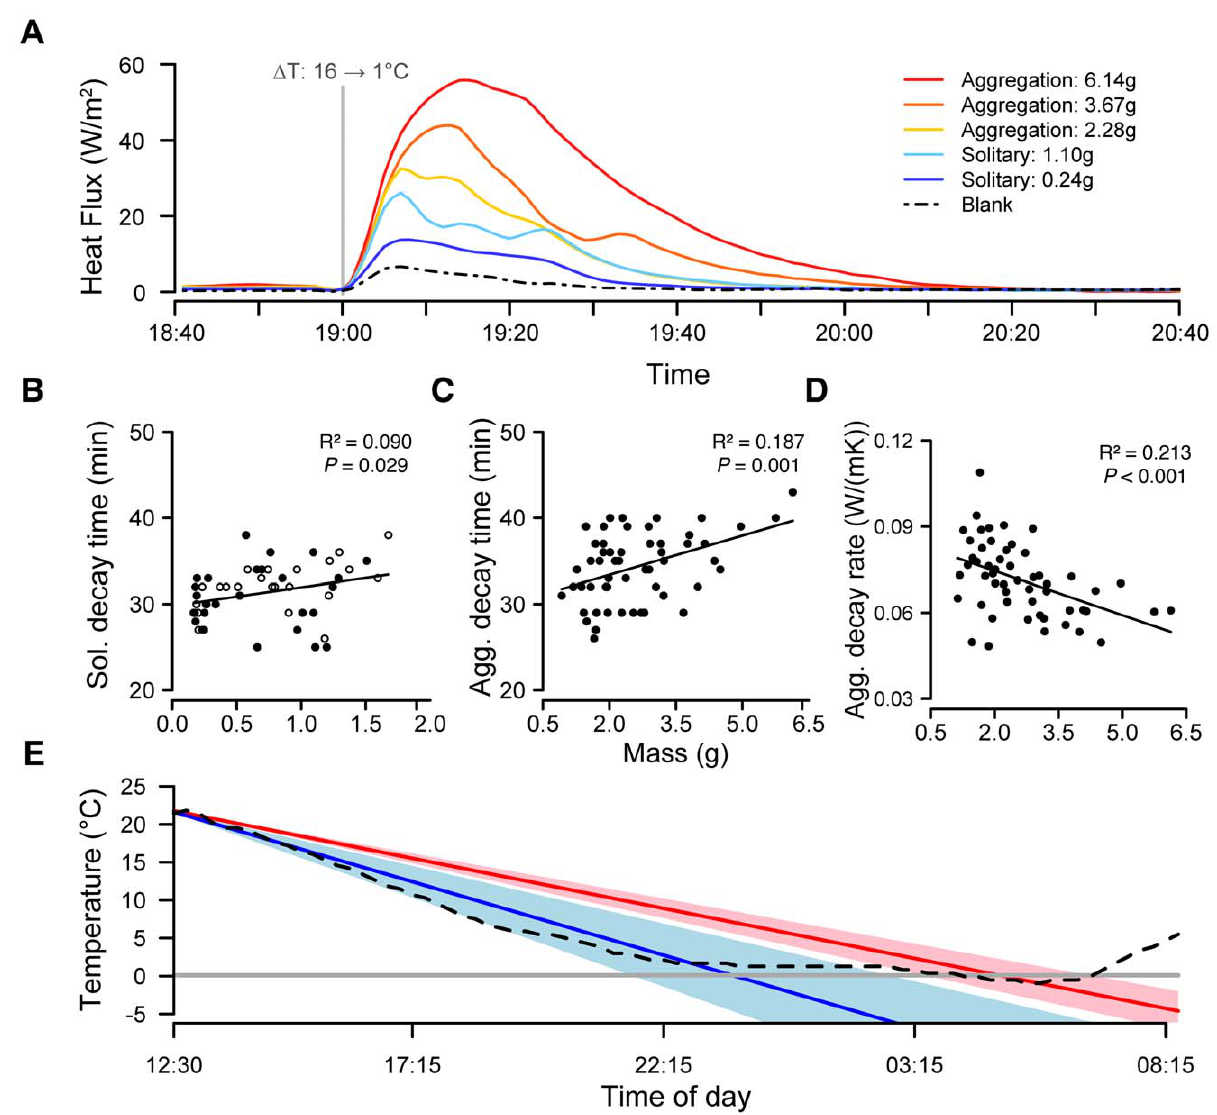
Figure 3. Rates of heat loss in solitary and aggregated night lizards. ( A ) Representative heat loss curves measured for two solitary lizards and three aggregations of different mass show that thermal stability increases with mass because lizards in large aggregations take longer than solitary lizards to return to equilibrium with environmental temperature. Properties of each curve are represented by single points in panels B–D. ( B ) Thermal decay time (two half-lives) for solitary lizards increases with mass (F 1,51 =5.07, P =0.029). There was no difference between naturally solitary (closed circles) and experimentally isolated (open circles) lizards (F 1,50 =0.59, P =0.45). ( C ) Thermal decay time (two half-lives) for lizard aggregations increases with mass (F 1,53 =12.16, P , 0.001). ( D ) Rates of thermal decay (heat loss) decrease as aggregation mass increases (F 1,52 =14.08, P , 0.001). ( E ) Rates of heat loss under natural conditions, as predicted from measured laboratory rates in (D), show that solitary neonates (blue) reach equilibrium with microclimate temperature (dashed black line; intersection) much earlier than aggregations greater than 4g (red) and spend more time at cold temperatures. Shading denotes 6 1 SD, and gray line at 0 u C shows environmental freezing point.